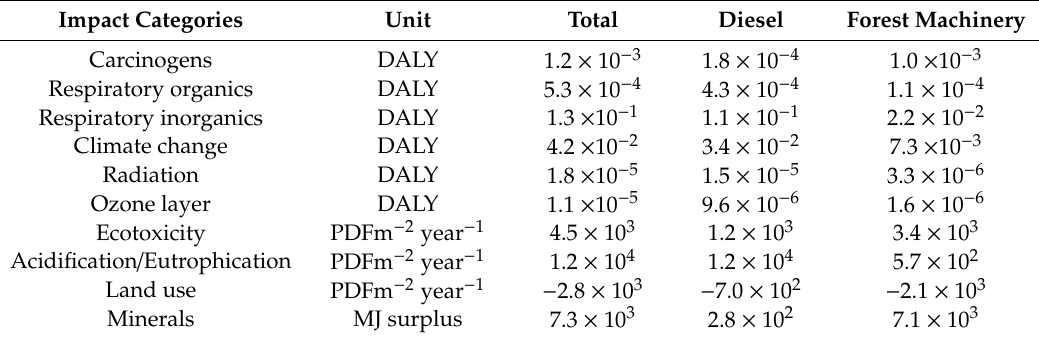
Table 2. Characterization of the total harvesting residues load